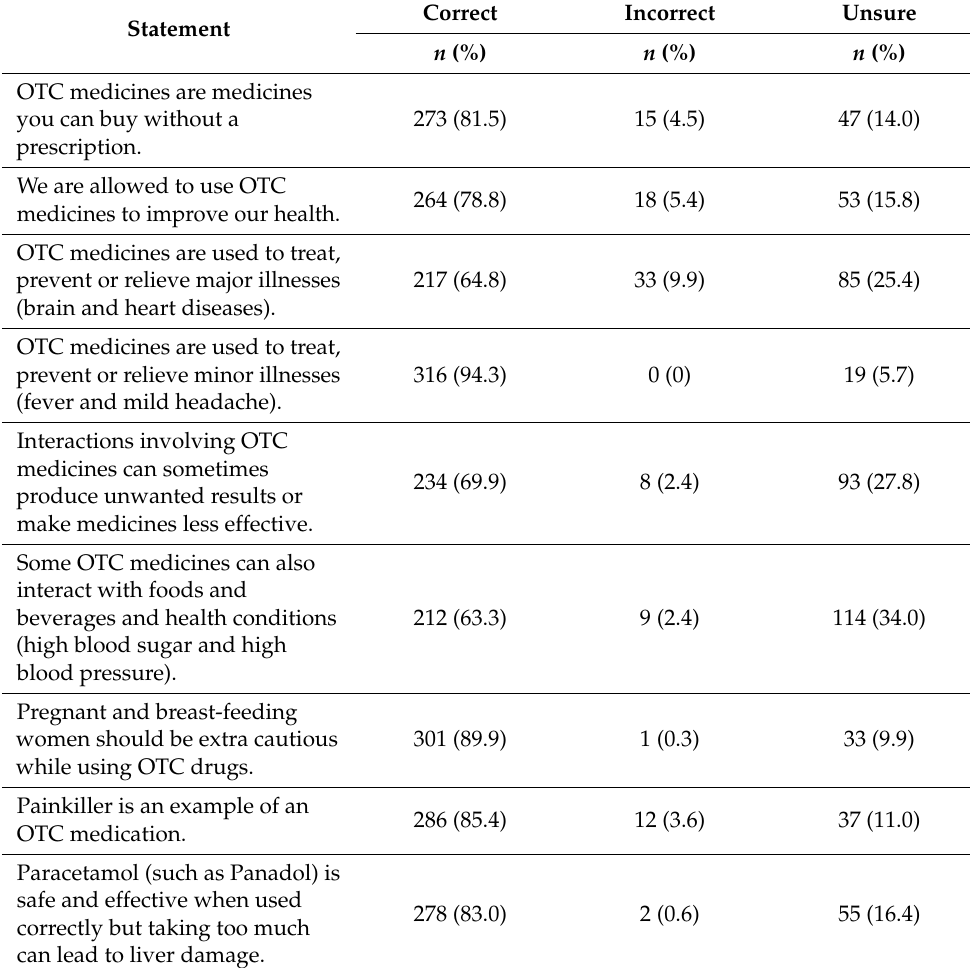
Table 2. Responses to knowledge of over-the-counter (OTC) medications ( n =